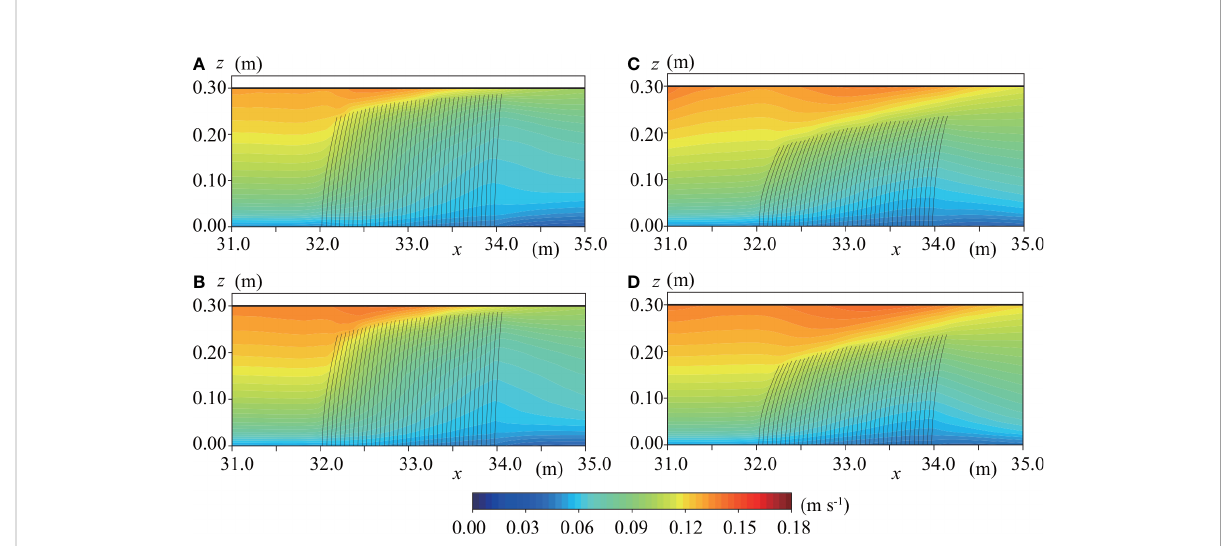
FIGURE 5 Horizontal velocity distributions at (A) L1 in case E2, (B) L4 in case E2, (C) L1 in case E2s, and (D) L4 in case E2s.